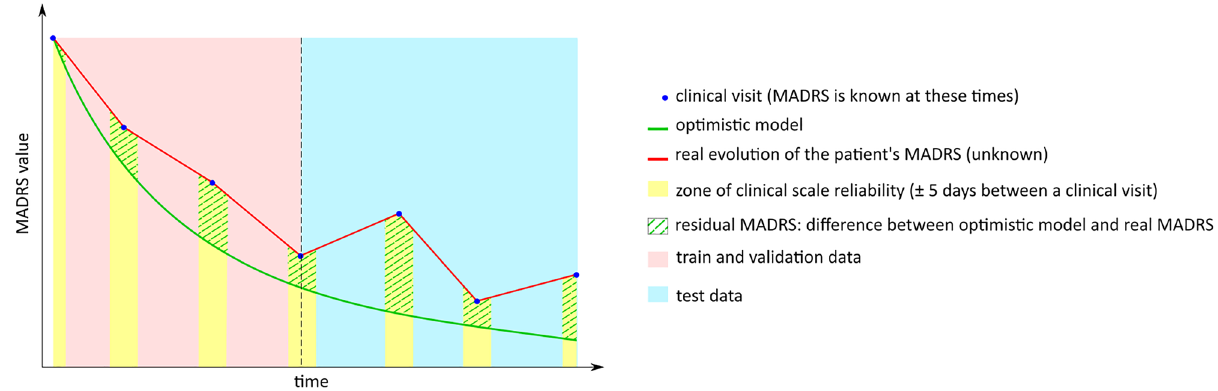
Figure 1. Label detrending procedure. This diagram shows how data and labels are handled and partitioned for the machine learning algorithm. The actual MADRS score is obtained only during clinical visits, although it can be safely extended to 5 days on either side of a clinical visit. The physiological data are available every day. The residual between the output of the optimistic model and the known MADRS score is used as a label for